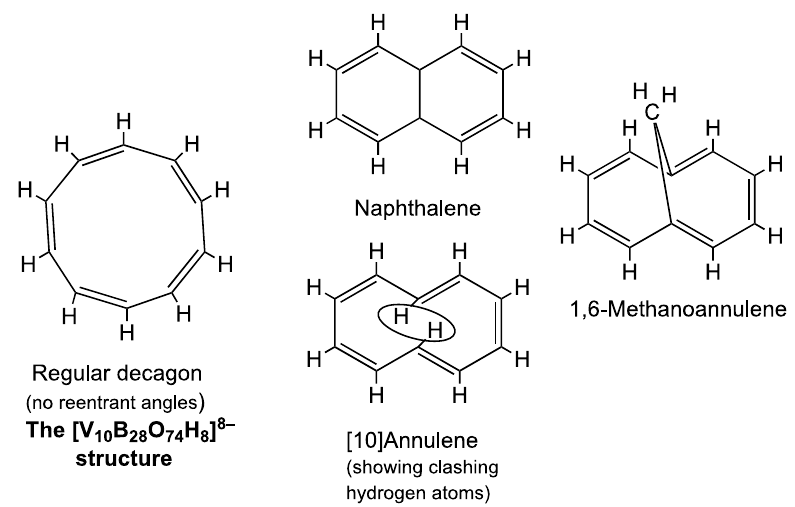
Figure 3. The structures of [10]annulene and related species.